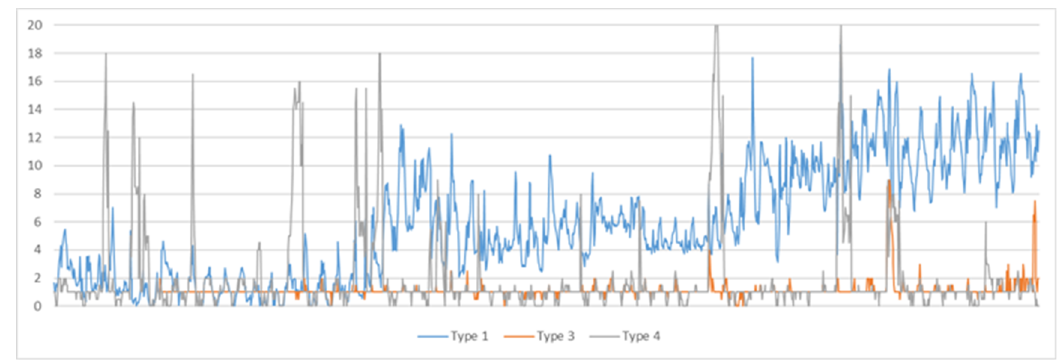
Figure 10. Hourly distribution of air velocity at three urban types (1, 3, and 4) in summer 2017.